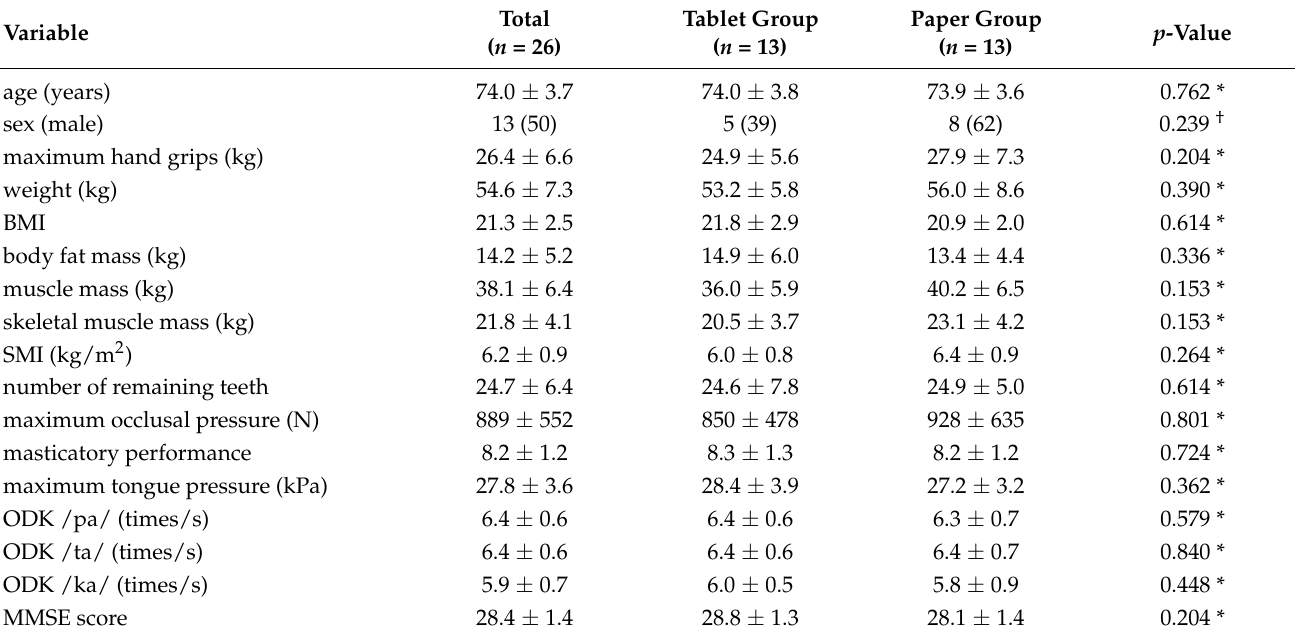
Table 2. Comparison of variables in the two groups stratified by the oral exercise method at the